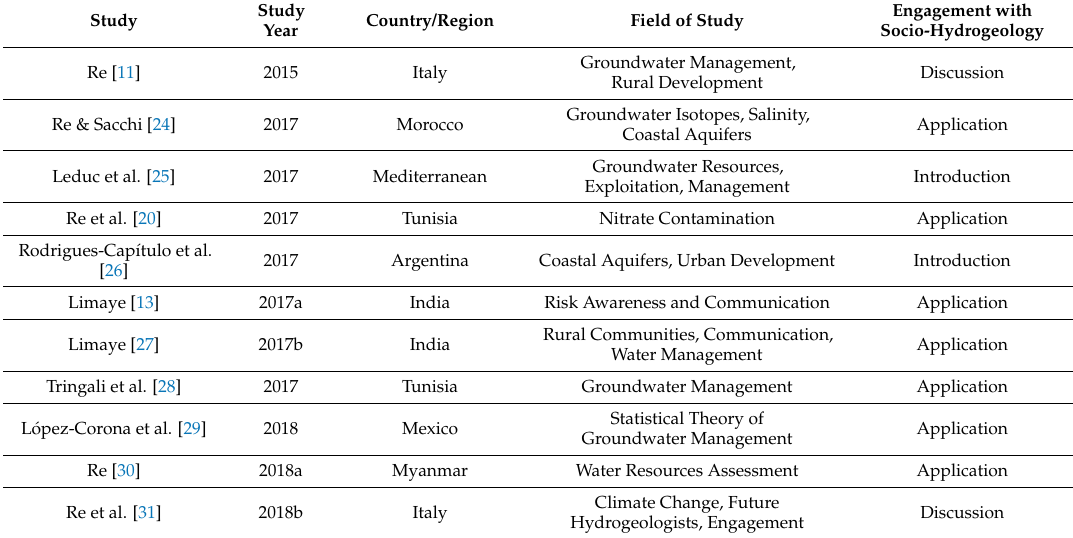
Table 1. Articles published to date (2015–2017) applying socio-hydrogeological